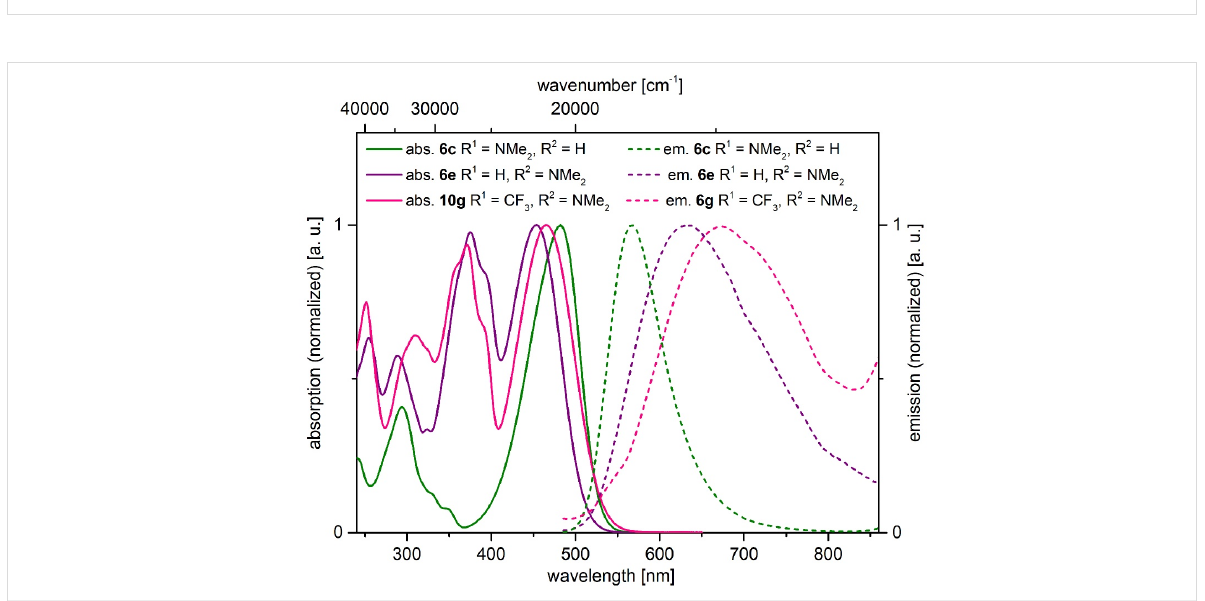
Figure 10: Selected normalized absorption (solid lines) and emission (dashed lines) spectra of α -pyrones 6c , 6e , and 6g recorded in dichloro- methane at T = 298 K.